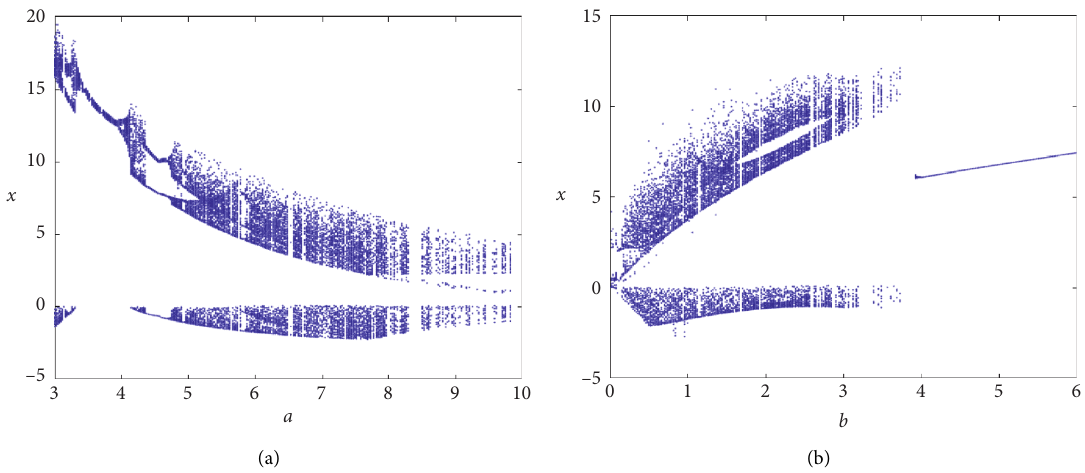
Figure 8: Dynamical properties of the fractional-order system with a and b varying. (a) a varying. (b) b